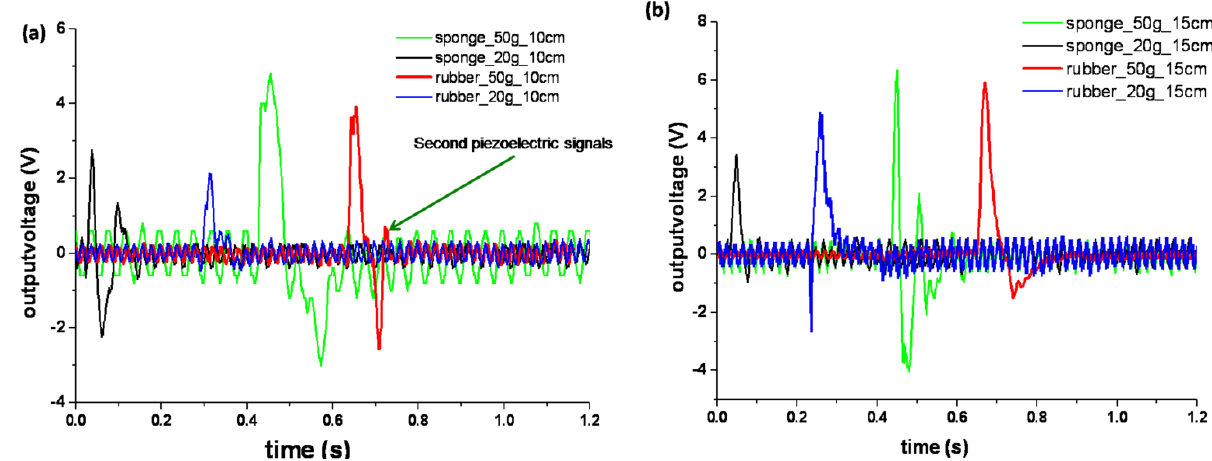
Figure 3. Response of PVDF sensors on sponge and rubber. ( a – c ) temporal response curves for the PVDF sensor prepared from 100 μm PVDF film, the weights were 50, 20 g, and the falling height was 10, 15, 20 cm; ( d ) the analysis of the peak-to-peak voltage (Vpp) vs. the impact energy for the same sensor prepared from 100 μm PVDF